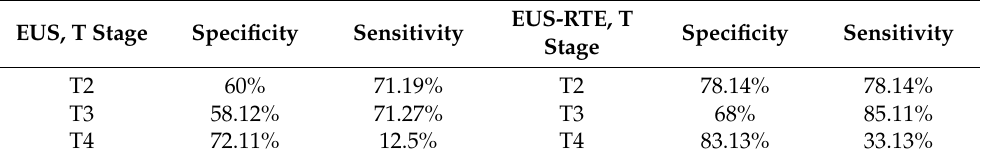
Table 2. Specificity and sensitivity, EUS_T and EUS-RTE_T.